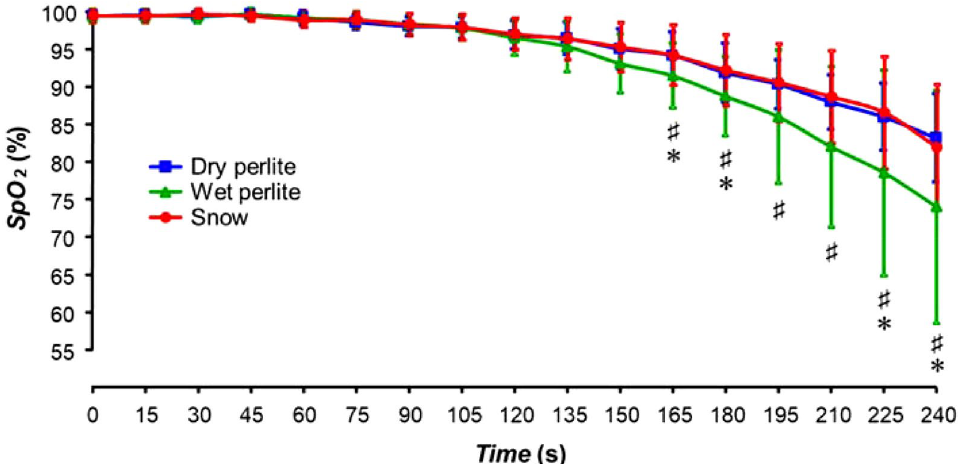
Figure 4. Peripheral blood oxygen saturation ( SpO 2 ) of the subjects during the three different phases: snow (S), dry perlite (PD) and wet perlite (PW). The symbol # represents statistically significant differences between snow and wet perlite, the symbol * represents statistically significant differences between dry perlite and wet perlite; p ≤